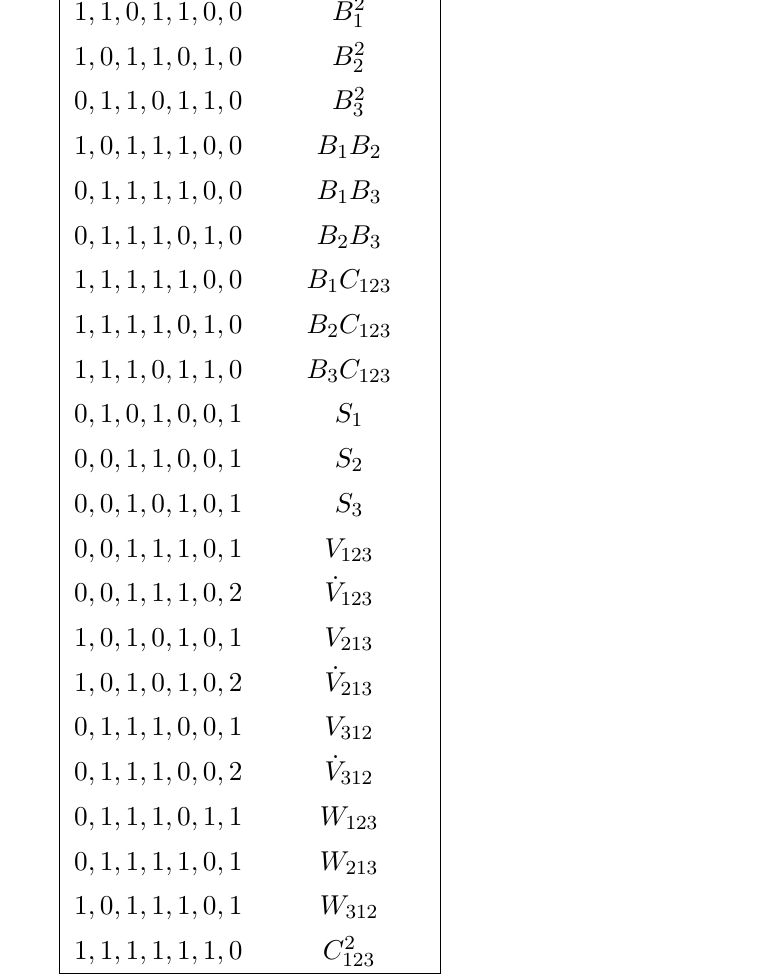
Table 1 . List of master integrals M ( i 1 , . . . , i 7 ) needed for the massless fully off-shell triangle at two-loop order. The last one is not needed at this